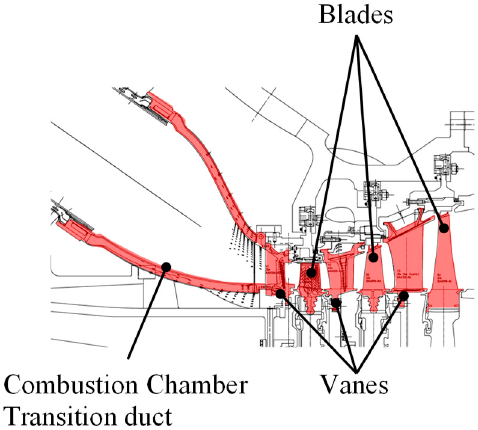
Figure 1. Gas turbine–Combustion chamber transition duct, turbine vanes and Figure 1 . Gas turbine–Combustion chamber transition duct, turbine vanes and blades.